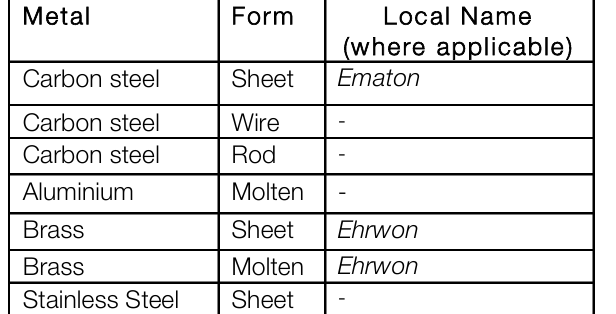
Table 1 | Some metals employed by blacksmiths in Benin City.